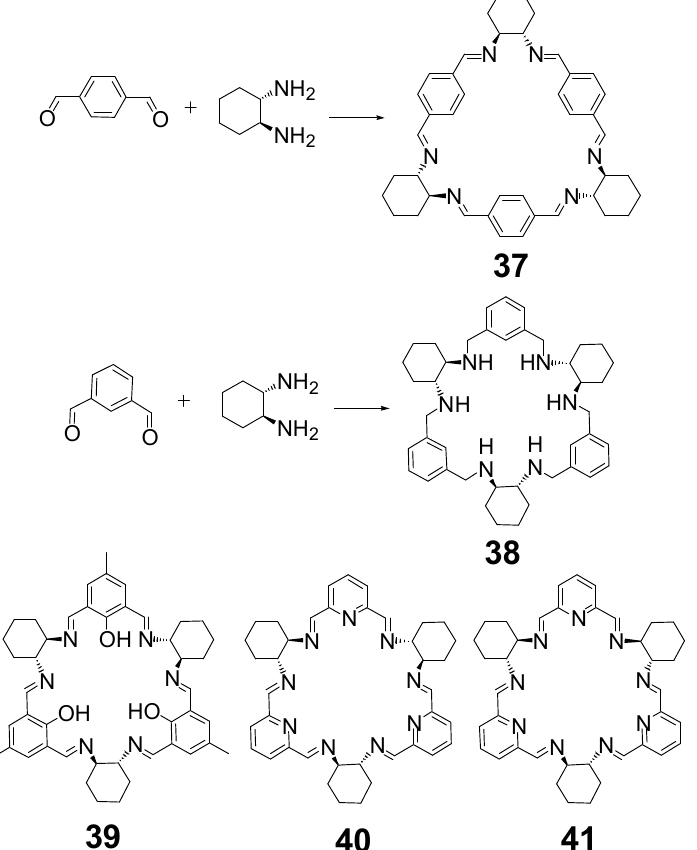
Figure 14. Examples of [3 + 3] imines derived from DACH.